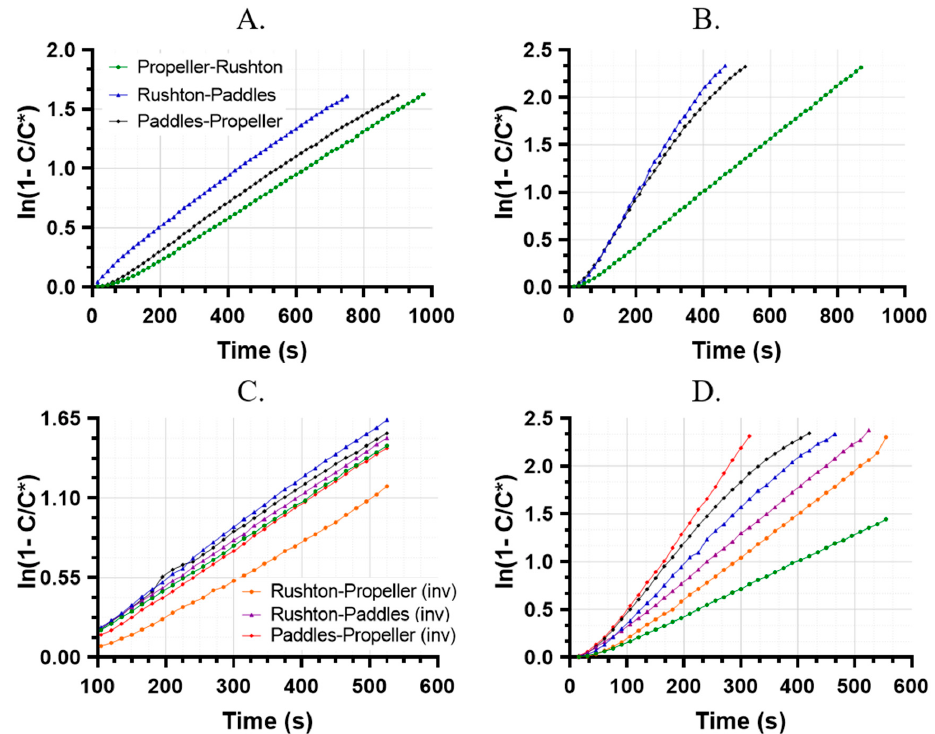
Figure A5. k L a determination for two impeller configurations: ( A ) 2.5 l min − 1 and 100 RPM; Figure A5. 𝑘 (cid:3013) 𝑎 determination for two impeller configurations: (A) 2.5 𝑙 𝑚𝑖𝑛 (cid:2879)(cid:2869) and 100 RPM; (B) 2.5 ( B ) 2.5 l min − 1 and 250 RPM; ( C ) 5 l min − 1 and 100 RPM; and ( D ) 5 l min − 1 and 250 𝑙 𝑚𝑖𝑛 (cid:2879)(cid:2869) and 250 RPM; (C) 5 𝑙 𝑚𝑖𝑛 (cid:2879)(cid:2869) and 100 RPM; and (D) 5 𝑙 𝑚𝑖𝑛 (cid:2879)(cid:2869) and 250 RPM